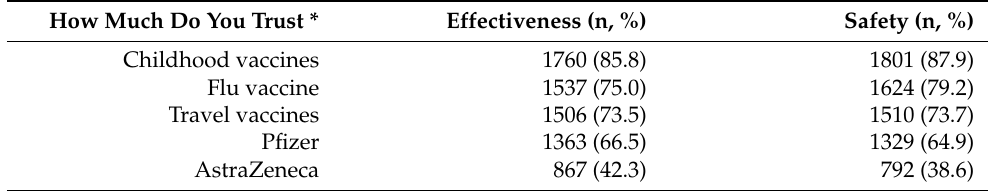
Table 3. Trust in vaccine effectiveness and safety.